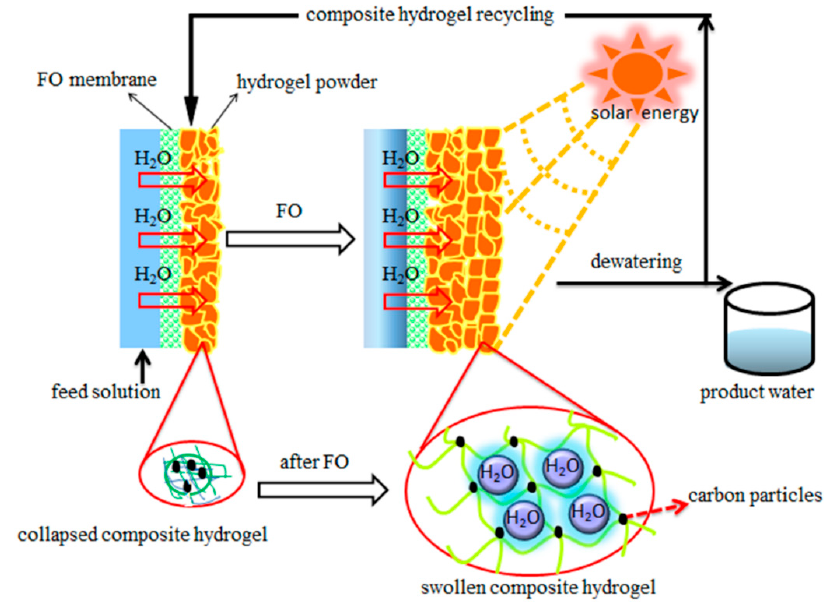
Figure 5. Schematic illustration of using solar energy to recover the thermoresponsive hydrogels DSs in the hydrogels ‐ driven FO process for desalination.